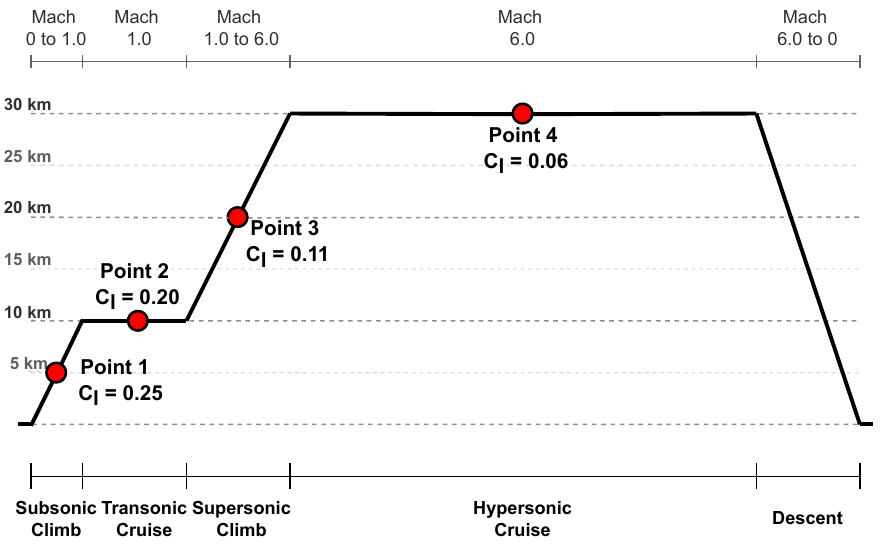
Figure 9. Mission